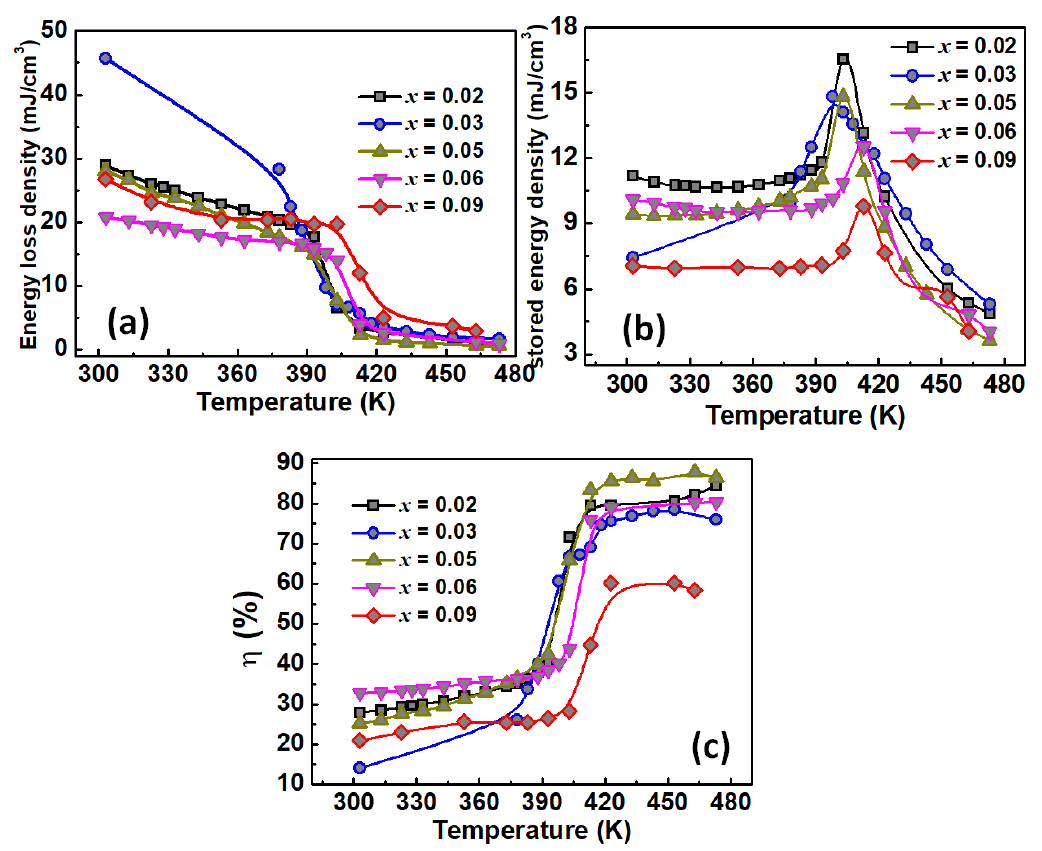
Figure 10. ( a ) Energy lost, ( b ) energy stored and ( c ) energy storage efficiency for all the BTGx compositions (x = 0.02, 0.03, 0.05, 0.06, 0.09). Energy loss decreases globally versus temperature for all the compositions. Maximal energy stored is obtained for BTG2. Higher energy storage efficiency is observed in